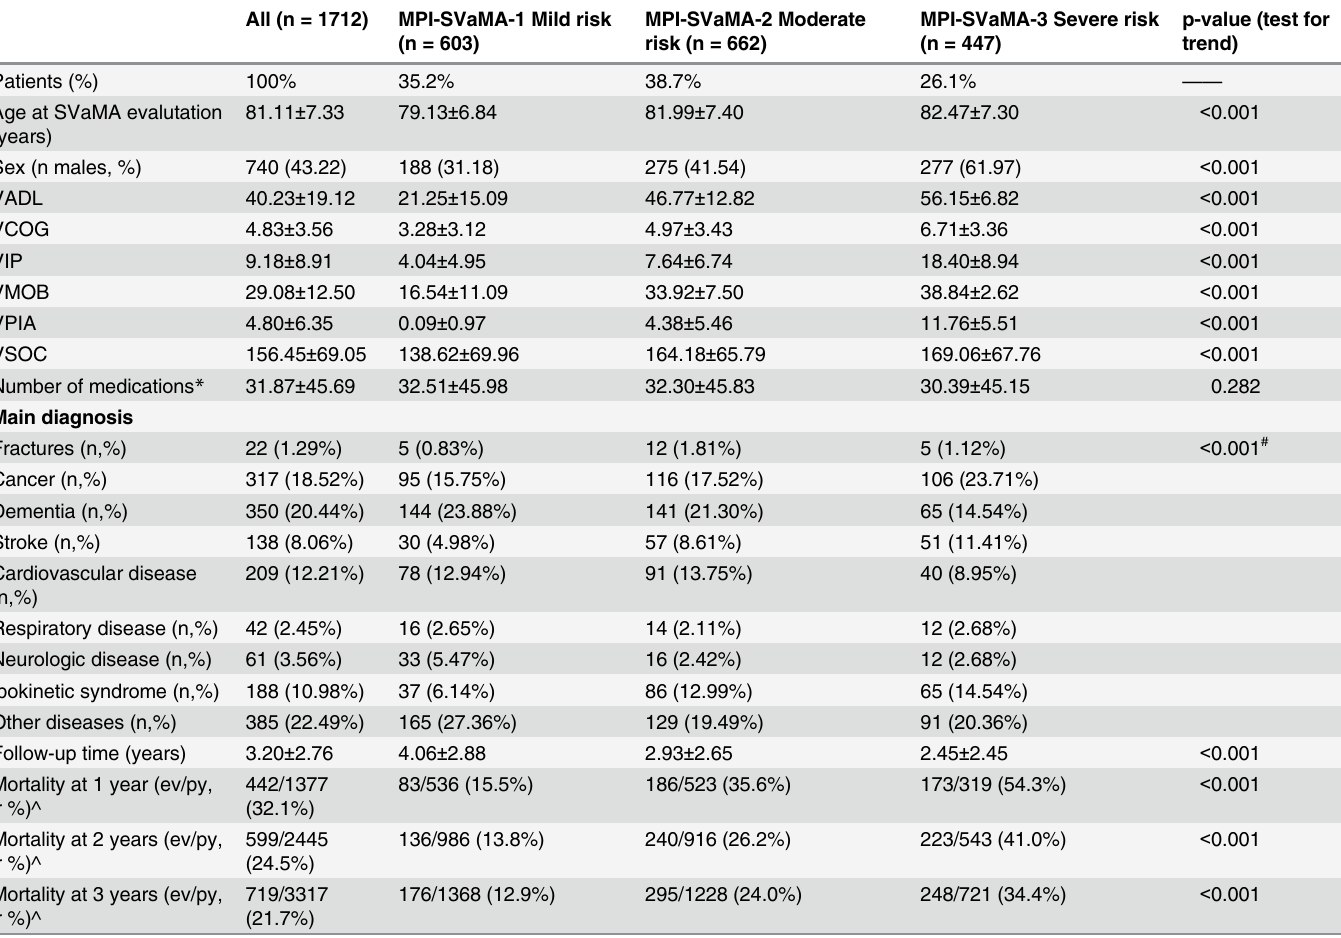
Table 1. Baseline characteristics of community-dwelling older patients with diabetes mellitus divided according to their Multidimensional Prog- nostic Index (MPI) grade based on the Standardized Multidimensional Assessment Schedule for Adults and Aged Persons (SVaMA). All (n =